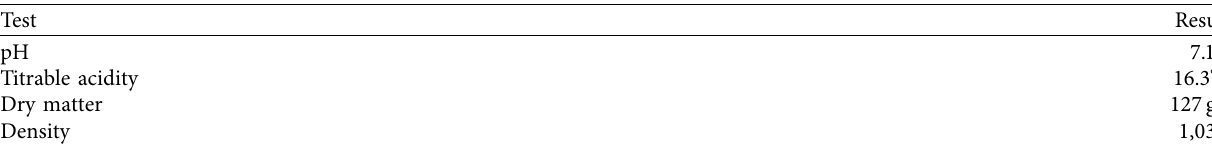
Table 2: Results of physicochemical parameters of donkey’s milk.